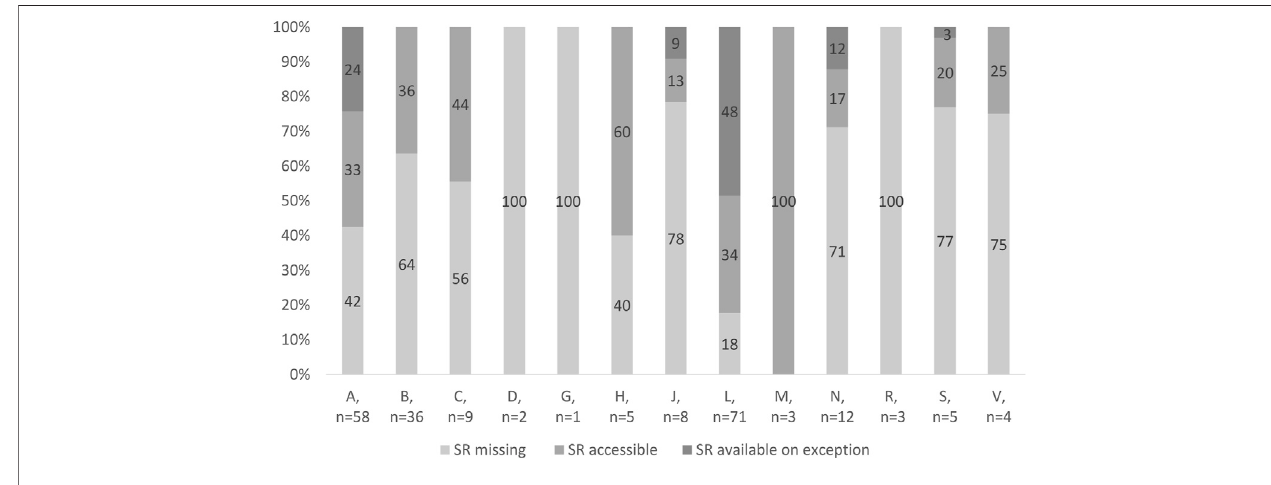
FIGURE 3 | Access to OMPs in Slovakia.